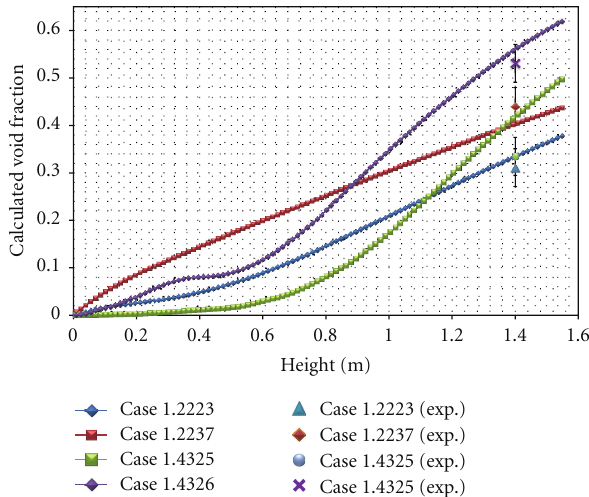
Figure 9: Axial void profile for 4 runs with S1 type of geometry.